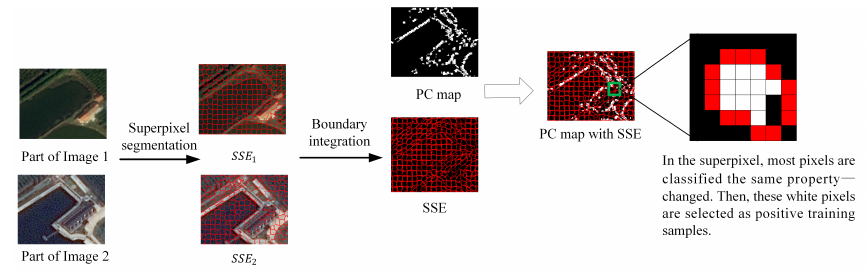
Figure 3. The diagram of sample